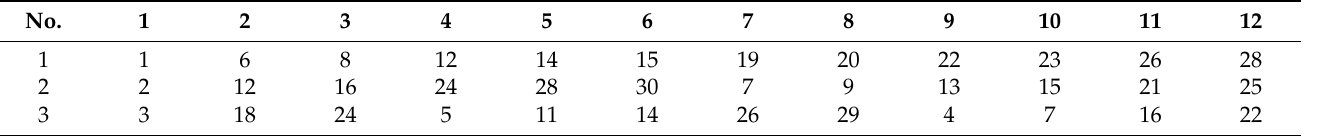
Table 5. Uniform design table of U 31 (31 12